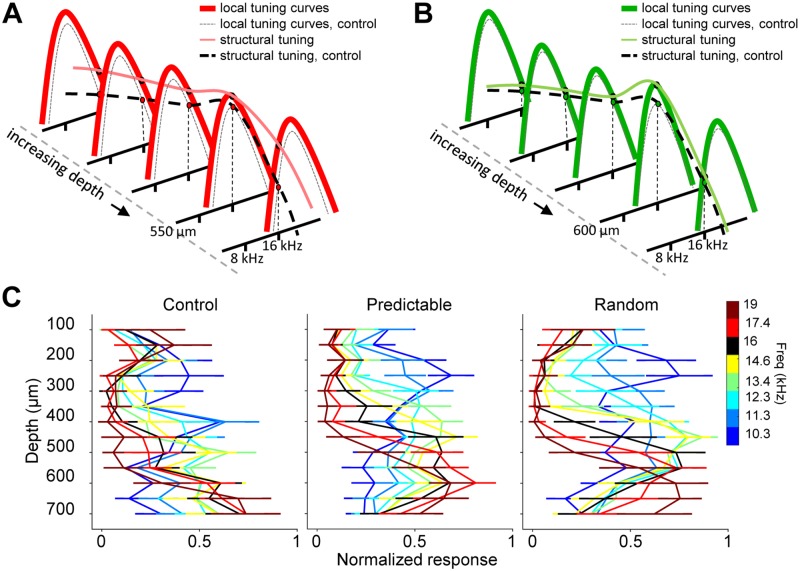
Predictable sound exposure modifies structural tuning.(A) Scheme of the local tuning curves and the structural tuning along the
collicular tonotopic axis for the predictable (red) and the control
(black) groups. (B) Same as A for the random (green) and the control
(black) groups. (C) Mean normalized structural tuning, evoked response
across depths, for a subset of frequencies (ANOVA, group × depth ×
frequency interaction F168,1869 = 2.34, p
< 0.0001). Animals and recording sites: control n =
10 and 98; predictable n = 14 and 162; random
n = 7 and 91. Numerical data for this figure found
in S1
Data.